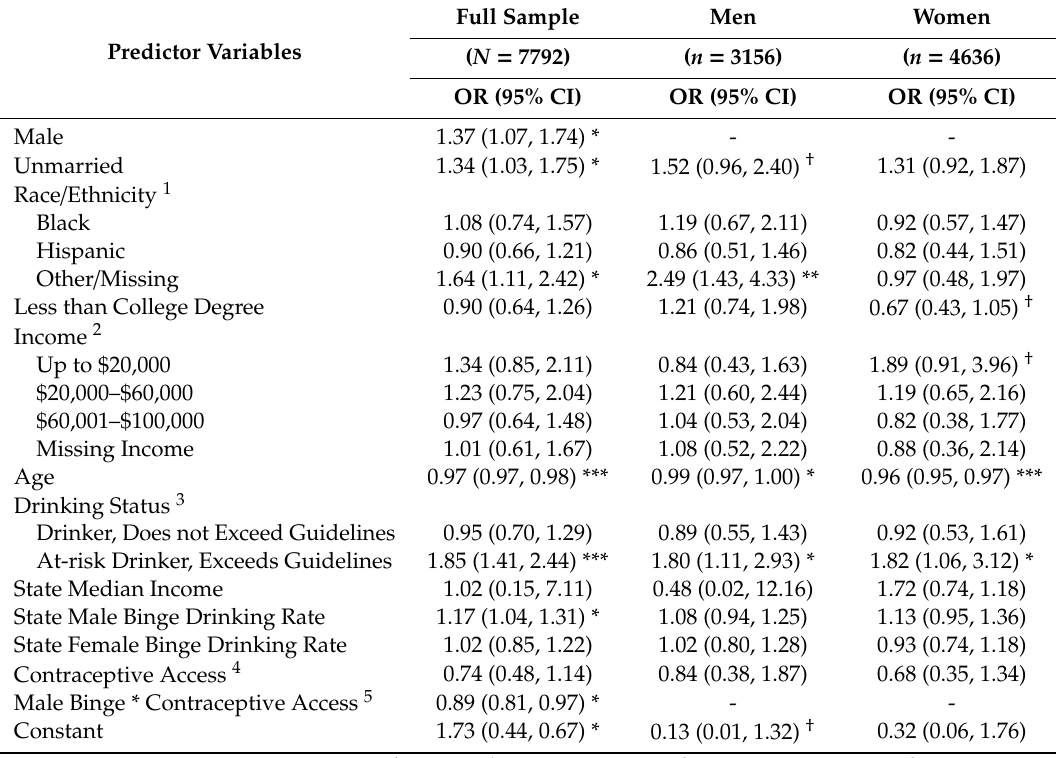
Table 3. Interactive associations of male binge drinking rates and contraceptive access with harm from drinking strangers.